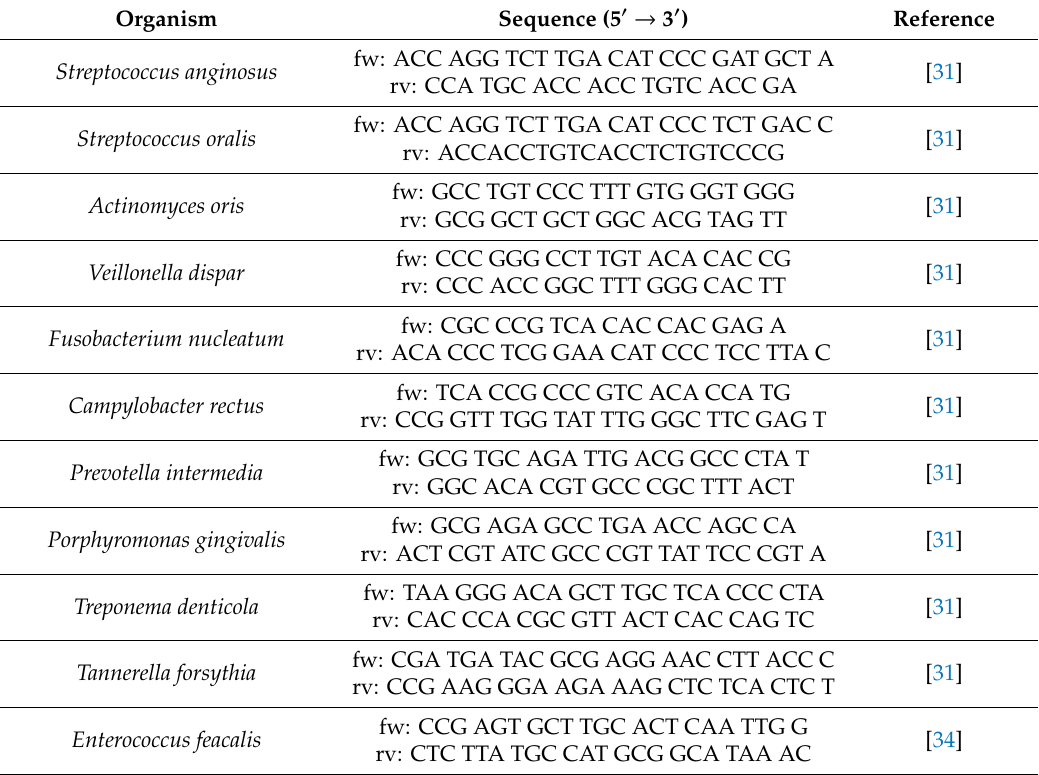
Table 1. Species-specific primer sequences used in this